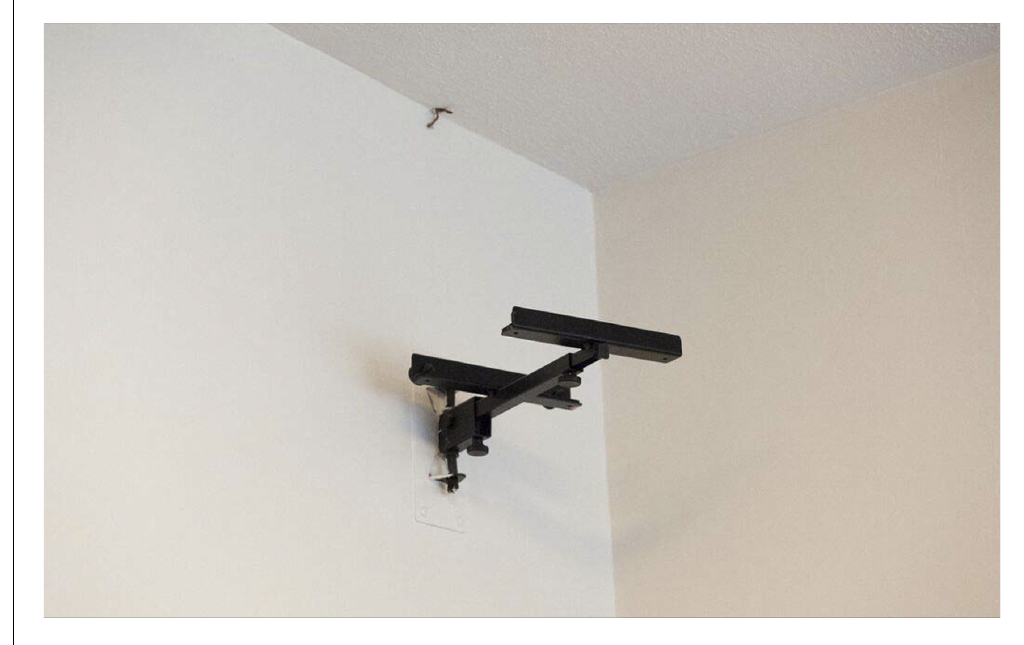
Figure 2. Empty TV cradle.